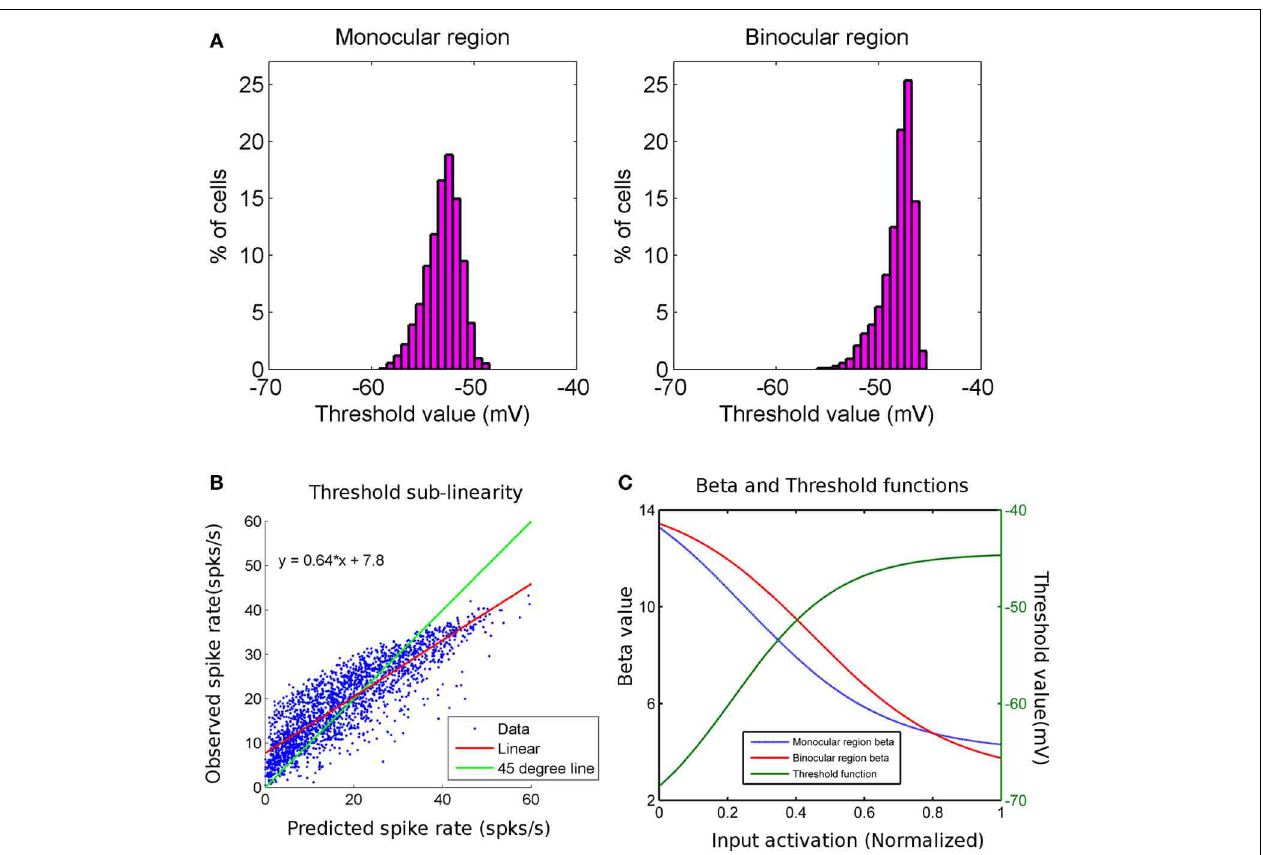
red line is the linear fit to data. The binocular spike rate is less than sum of individual monocular spike rates for higher spike rates. (C) Plots of β function of cells in monocular region (blue) and that in binocular region (red) (y-axis on left) with normalized input activation. β decreases as input activation increases. Plot for the threshold value (green) for all cortical cells with normalized input activation. Threshold value increases as input activation